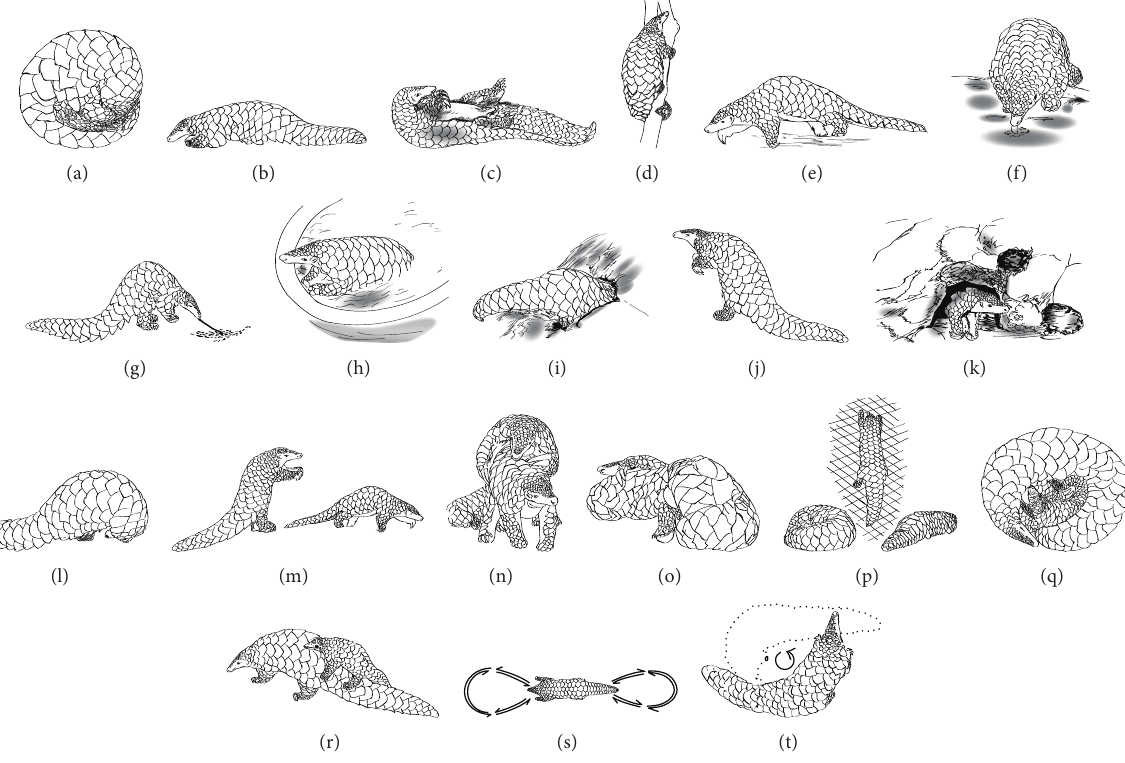
Figure 1: (a) Resting in coiled posture, (b) resting in a straight posture, (c) laying on back, (d) climbing, (e) walking, (f) drinking, (g) feeding, (h) bathing, (i) digging, (j) bipedal stand, (k) secretive look, (l) head bend towards ventral surface in defence, (m) bipedal chase, (n) mounting, (o) copulation, (p) retreat, (q) baby pangolin suckling, (r) baby pangolin on her mother’s back, (s) pacing in “8” shape, and (t) pacing in “O”